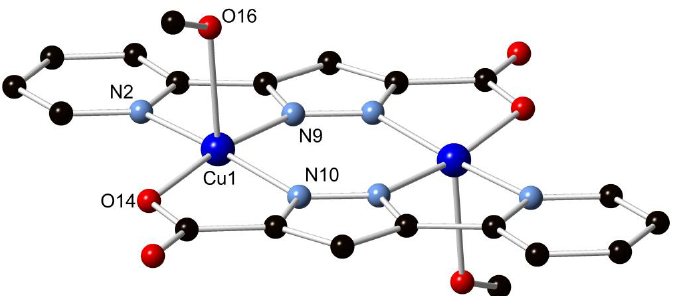
Figure 2. Structure of 1 with partial atom labelling scheme. Hydrogen atoms are omitted for clarity.